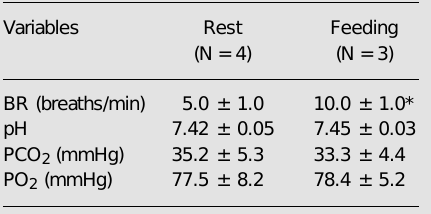
Data are reported as means ± SD. Five measure- ments were made for each sloth. *P<0.05 vs rest (Student t -test for unpaired